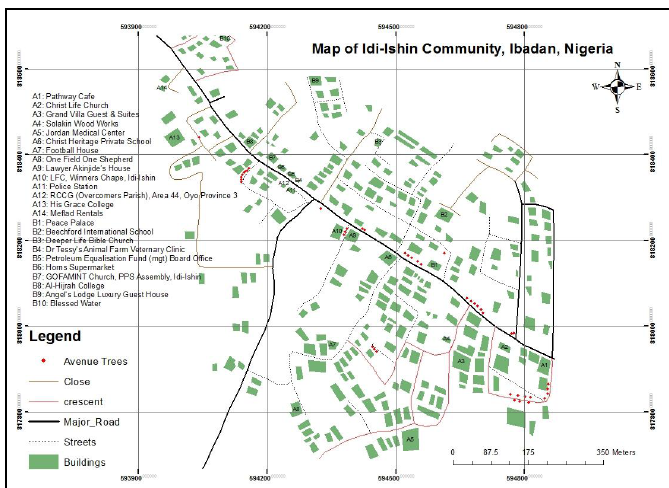
Figure 3. Produced Map of Idi-Ishin